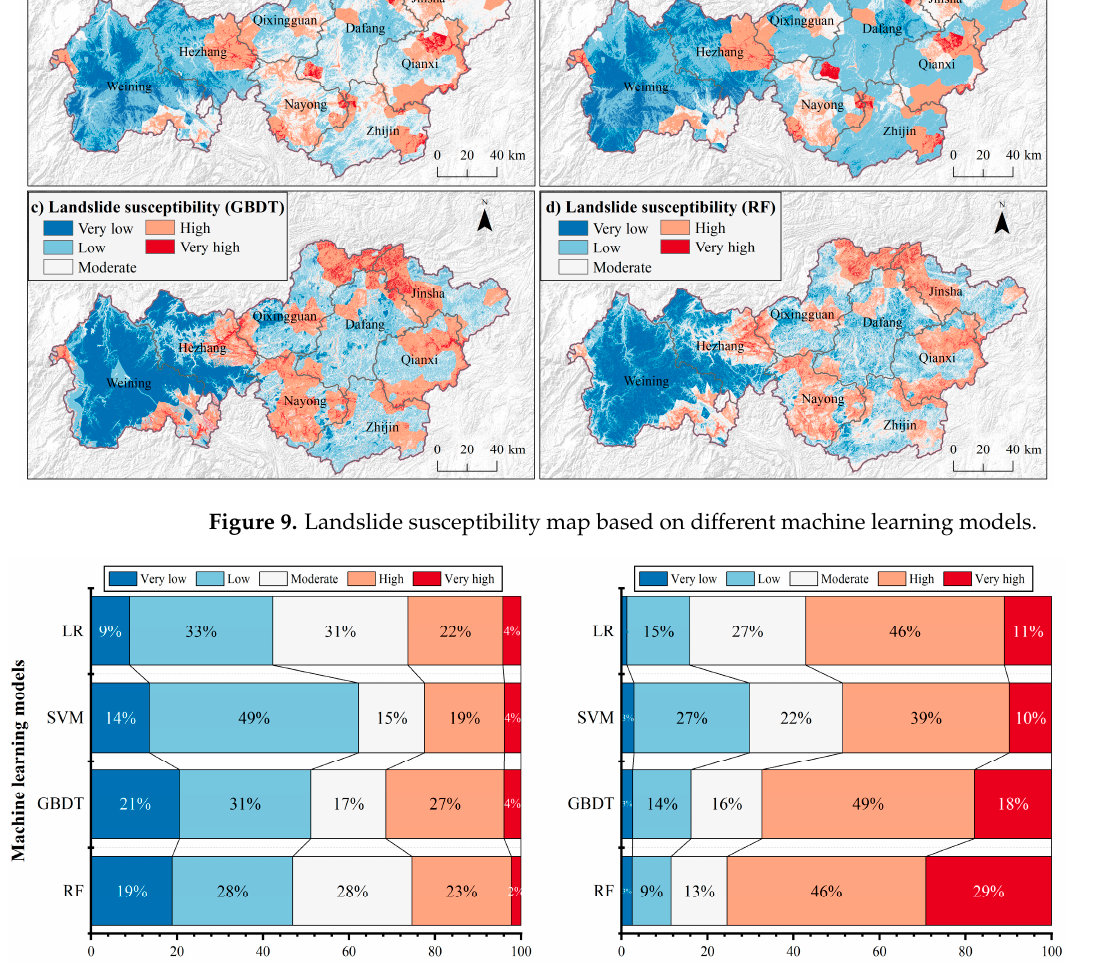
ISPRS Int. J. Geo-Inf. 2022 , 11 , x FOR PEER REVIEW 10 of 13